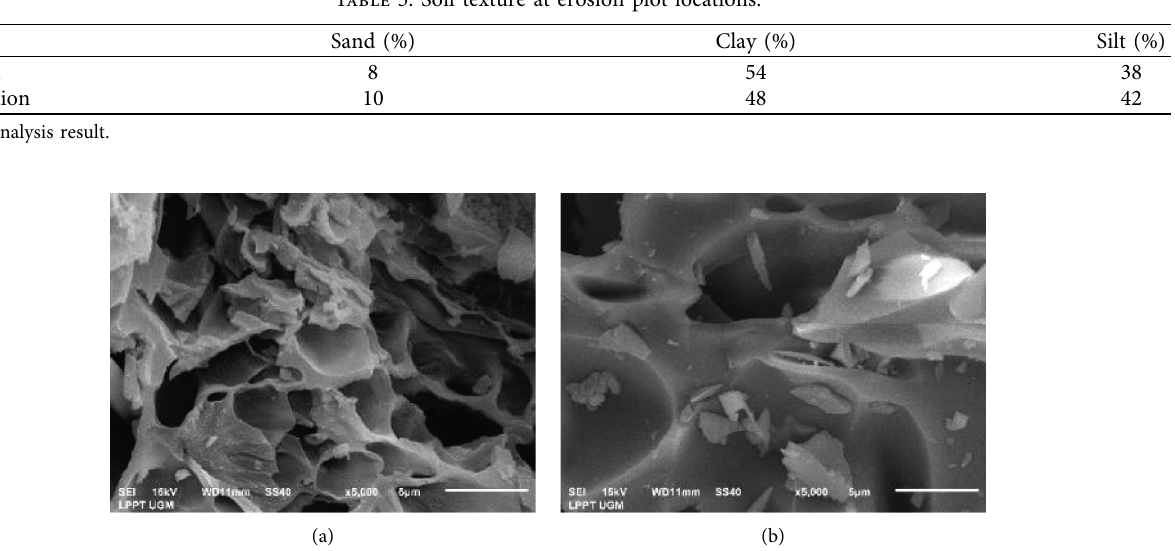
Table 5: Soil texture at erosion plot locations.